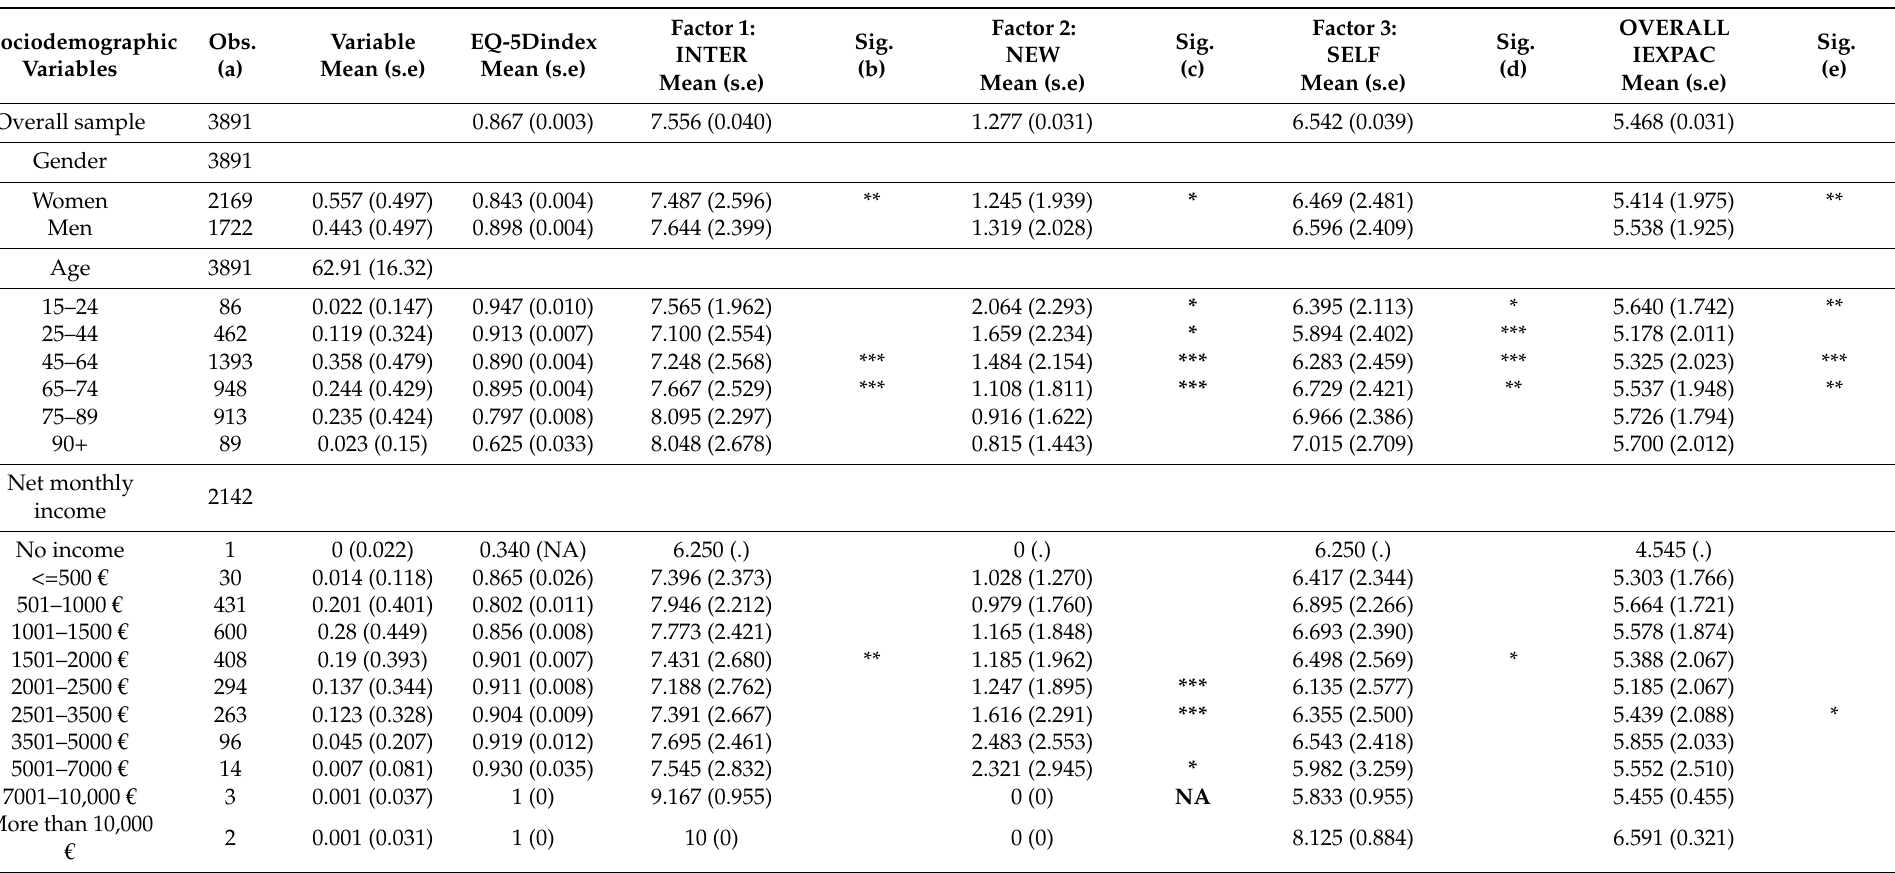
Table 1. Sociodemographic variables (*). Descriptive